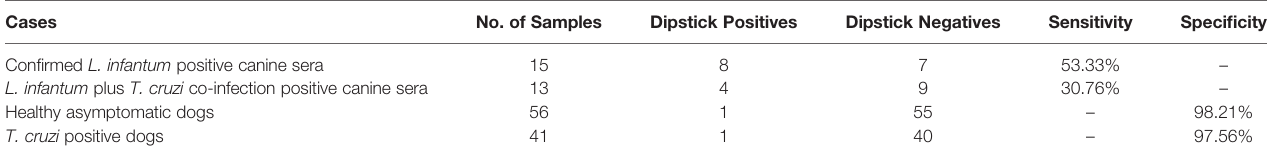
TABLE 3 | Performance of dipstick test at Universidade Federal do Rio de Janeiro (UFRJ) on pre-diagnosed dogs from endemic Paraiba State, Brazil.